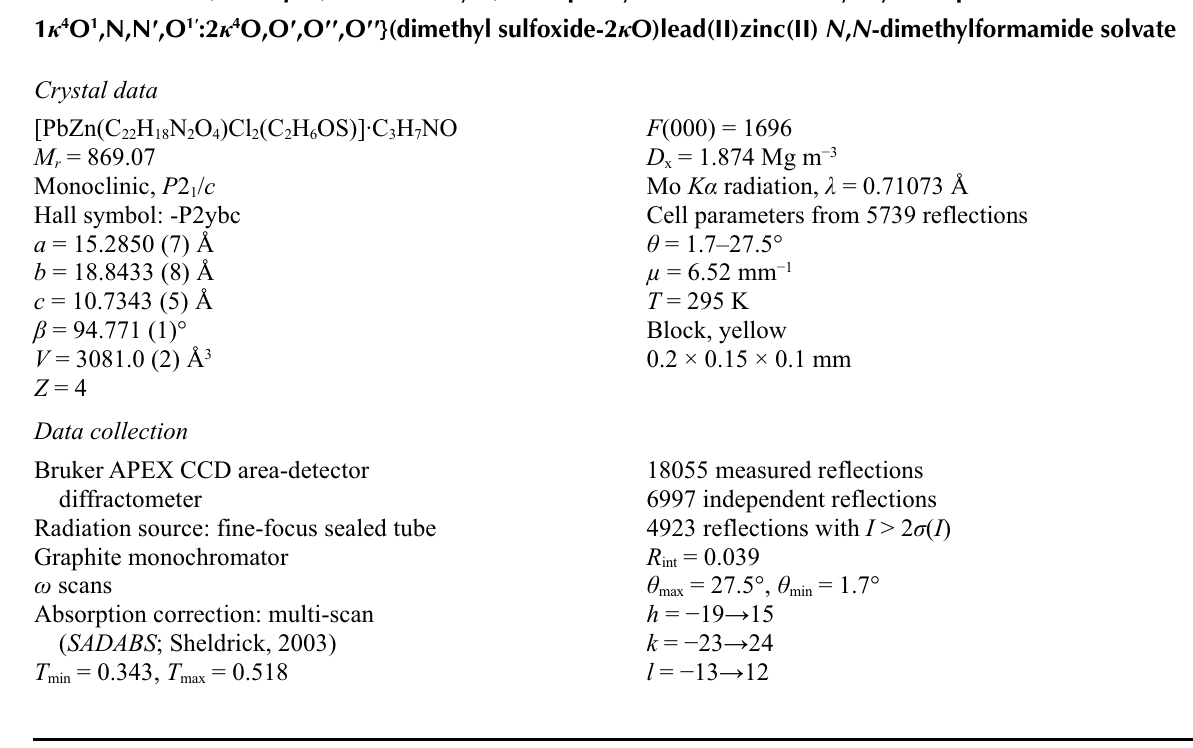
A view of (I) with the unique atom-labelling scheme. Displacement ellipsoids are drawn at the 30% probability level, all hydrogen atoms are omitted for clarity. Only one conpoment of the disordered DMSO molecule is shown. Dichlorido-1 κ Cl,2 κ Cl-{ µ -6,6 ′ -dimethoxy-2,2 ′ -[o-